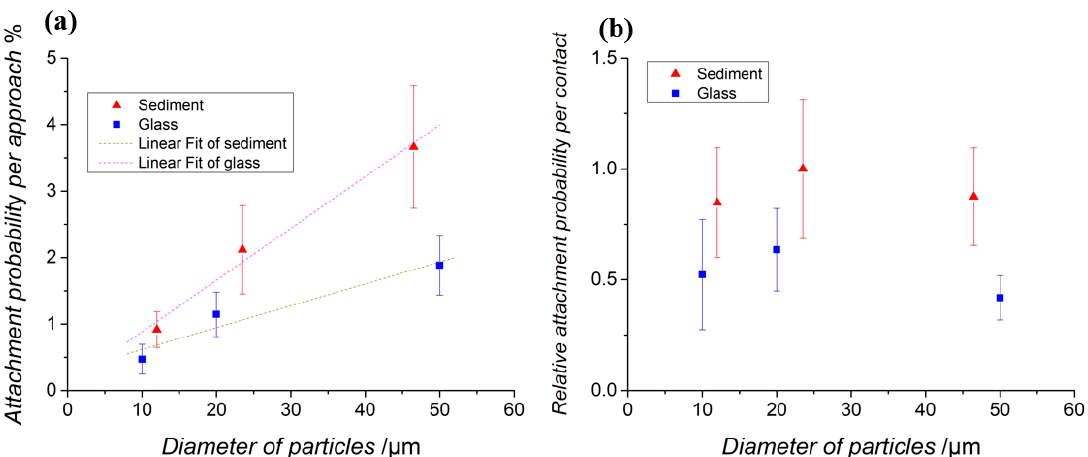
Figure 3. The relation between attachment probability and the diameter of particles for both sediment particles and glass microspheres. ( a ) The relation between p ap and D. Lines are linear fittings of the corresponding data. ( b ) The relation between relative p c and D. The base p c was for 20 μ m sediments.